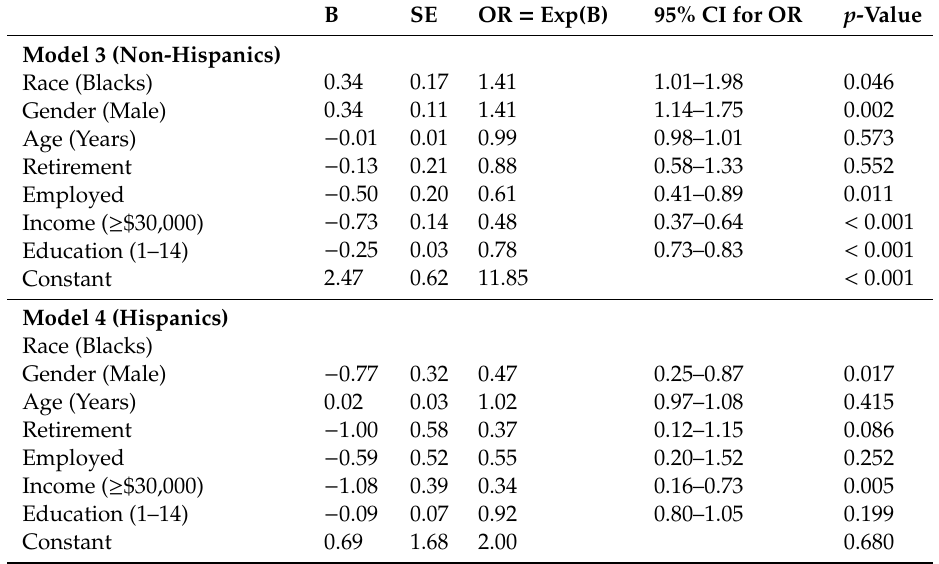
Table 4. Associations between educational attainment and poor oral health in the non-Hispanics and Hispanics.